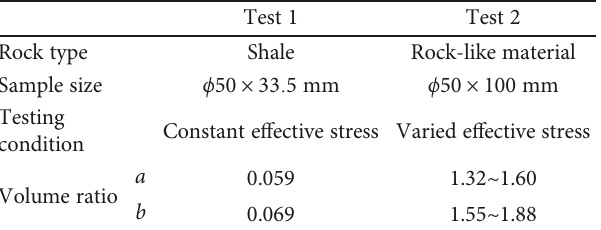
Figure 6: Experimental setup for pulse-decay permeability measurements. 1: gas cylinder; 2: air booster pump; 3: gas reservoir; 4: pressure reducing valve; 5: vacuum pump; 6: upstream chamber; 7: triaxial cell; 8: rock sample; 9: di ff erential pressure transducer; 10: downstream chamber; 11: constant temperature oven; 12: computer; 13: data acquisition system; 14: hydraulic water pump. Table 3: Experimental schemes of test 1 and test